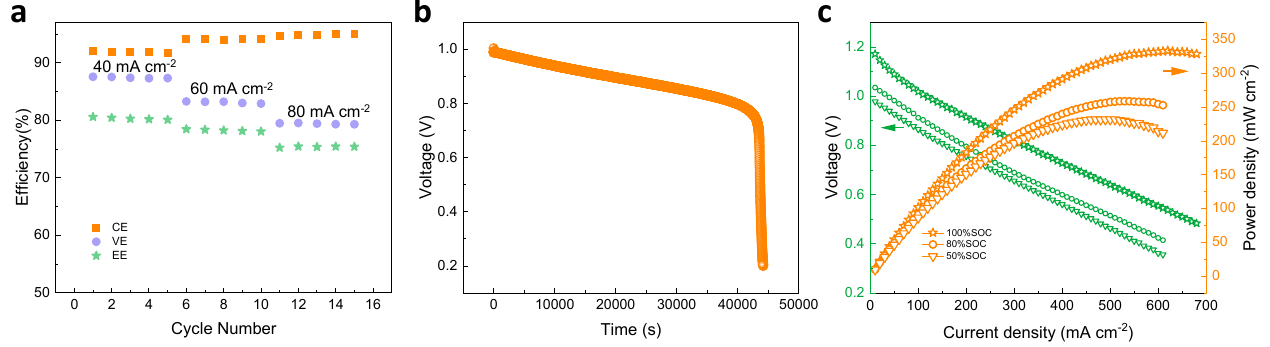
Figure 9. ( a ) The rate performance of an ICFB with D ‐ DMAc ‐ 8 membrane at the current density of 40–80 mA cm − 2 ; ( b ) OCV curves of ICFBs with D ‐ DMAc ‐ 8 membrane; ( c ) polarization curve and power density of an ICFB with D ‐ DMAc ‐ 8 membrane at different SOC (100%, 80% and 50%).